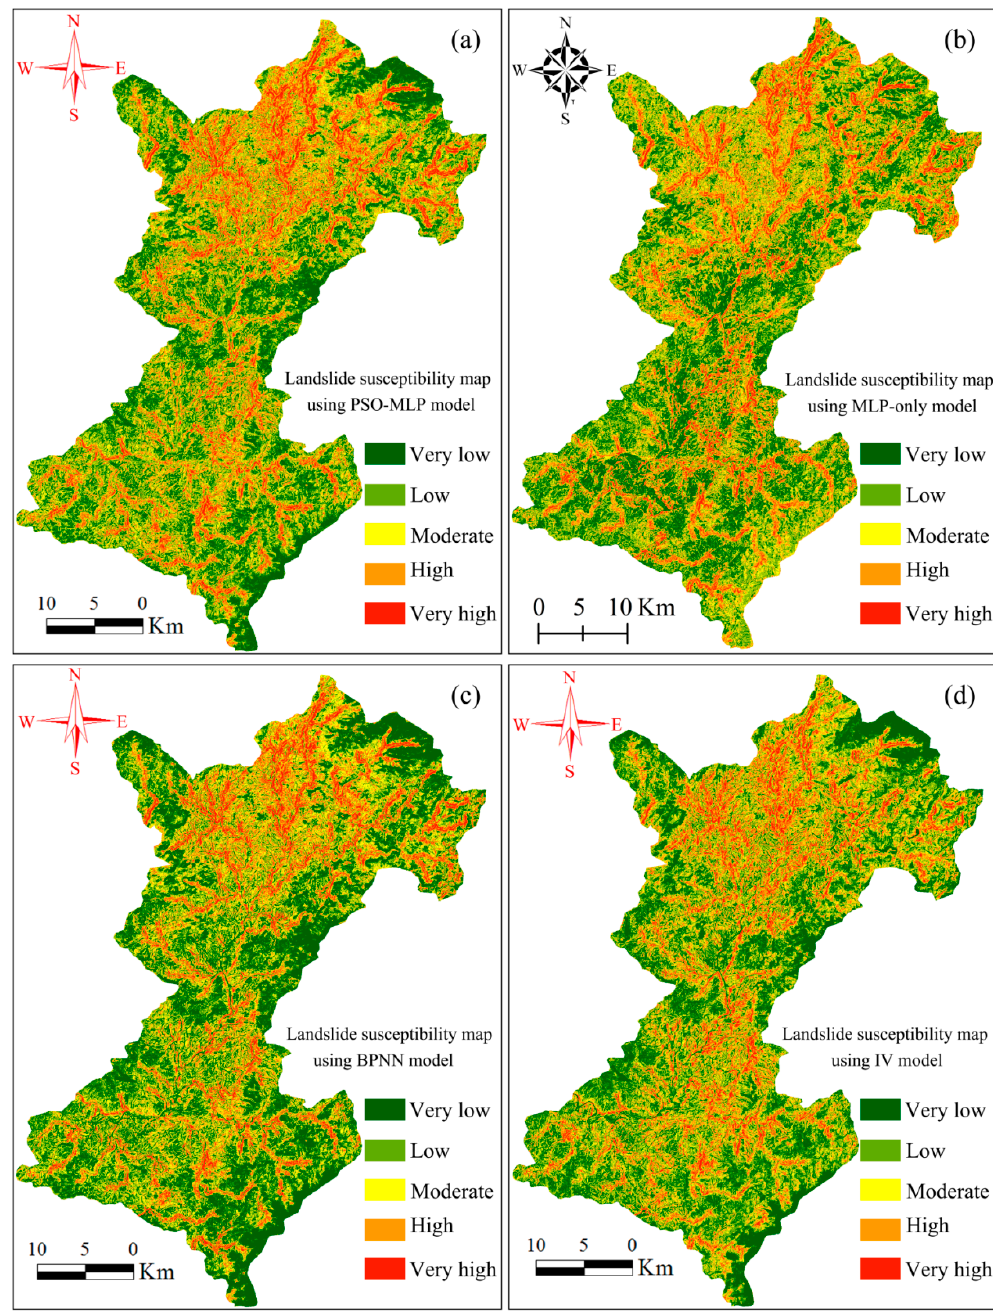
Figure 6. Landslide susceptibility maps respectively produced by PSO-MLP ( a ), MLP-only ( b ), BPNN ( c ), and IV ( d ) models.